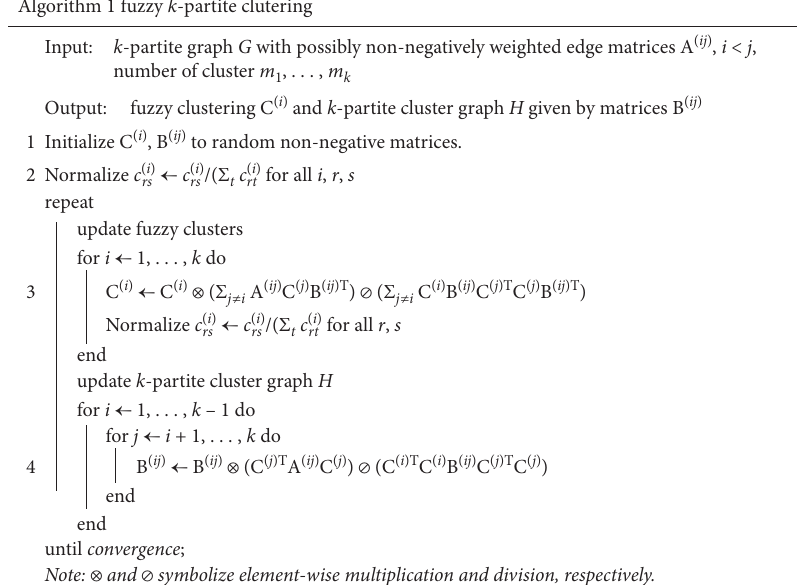
Algorithm 1 fuzzy k -partite clutering